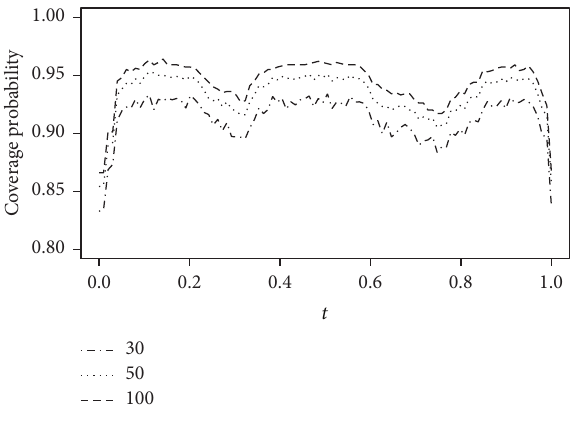
Figure 1: The pointwise confidence intervals for 𝜃(𝑡) . Table 1: The estimators and the 95 % confidence intervals for 𝛽 .